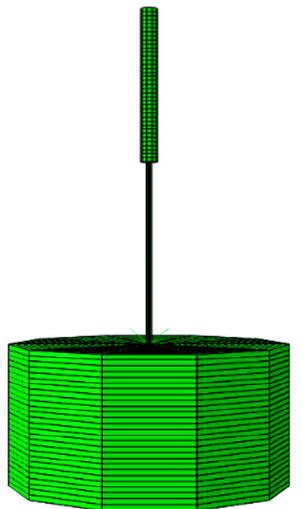
Figure 7. The asphalt penetration model.